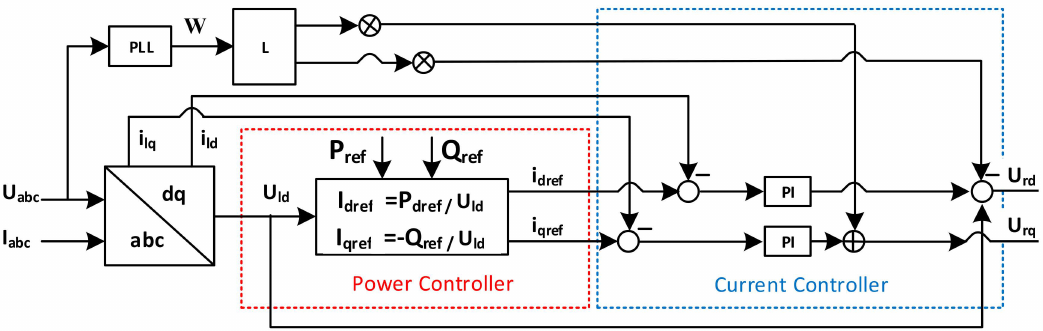
Figure 11. P-Q control structure